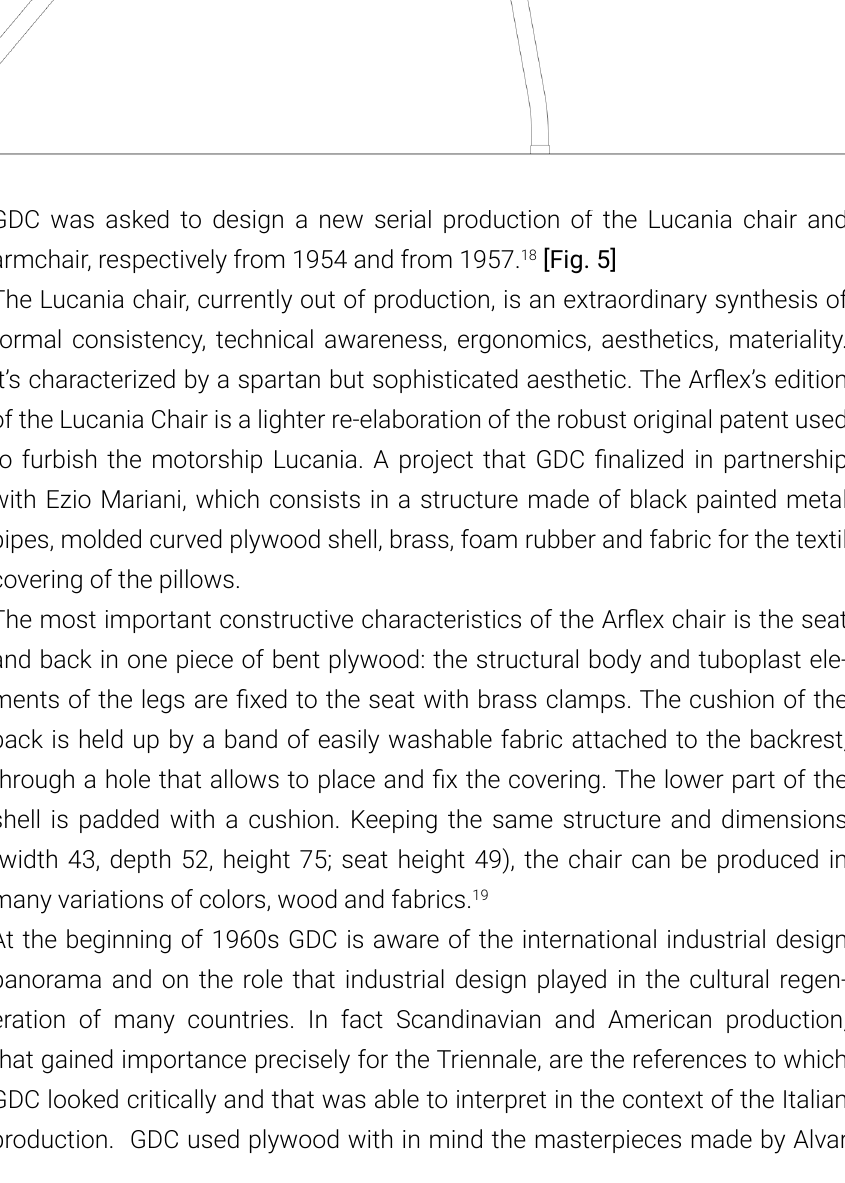
Technical drawing of Chair and Armchair Lucania, reproduced from Original work drawings by